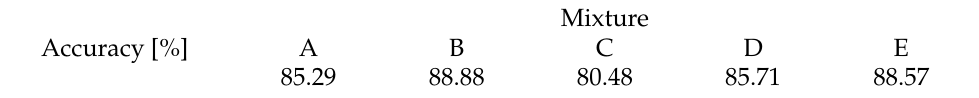
Table 5. Classification accuracy among all tested mixtures.